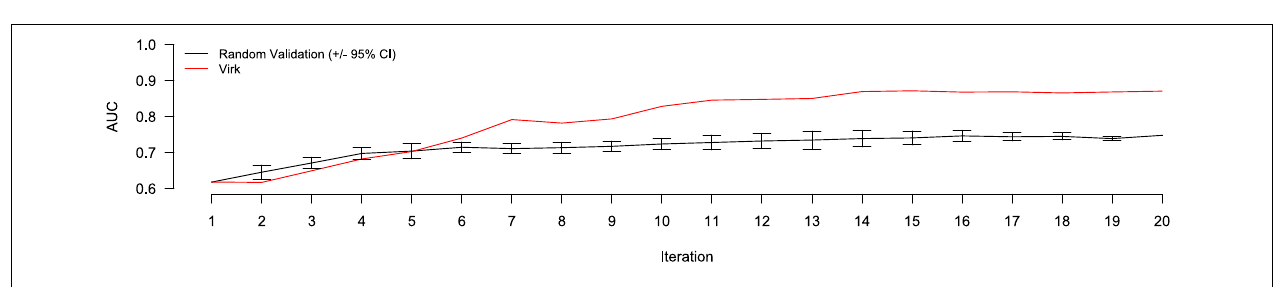
FIGURE 3 | Relative performance of a system trained using only the uncertain documents at each iteration of active learning (black), versus all documents annotated up to that point (red), in terms of AUC. At Iteration 1, both systems are trained using the same data (the 100